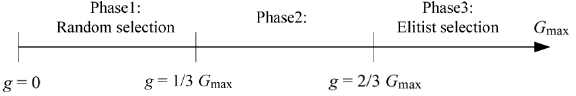
Fig. 3. Adaptive mutation